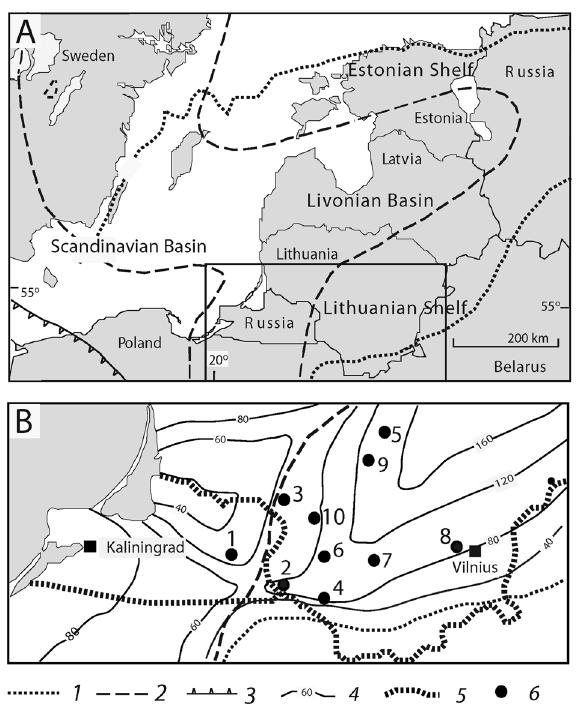
Fig. 2. A , major palaeogeographic features of the Baltic Basin (after Harris et al. 2004). B , localities of drill core sections with described brachiopods: 1, Nesterov-1; 2, Pajevonys-13; 3, Jurbakas-36; 4, Kalvarija-2; 5, Krekenava-7; 6, Sasnava-6; 7, Prienai-3; 8, Vilnius (Griškekes)-1; 9, Ledai-179; 10, Sutkai-89. Legend: 1 , outer limit of the distribution of Ordovician deposits; 2 , boundary between main facies belts; 3 , Caledonian front; 4 , isopachs (m) (Paškevi č ius 1997); 5 , administrative boundary;